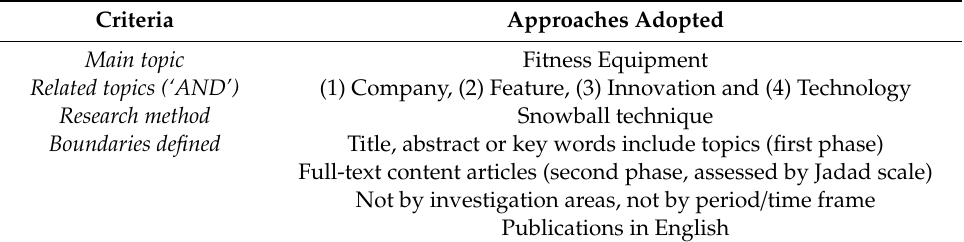
Table 1. Traditional literature review criteria and